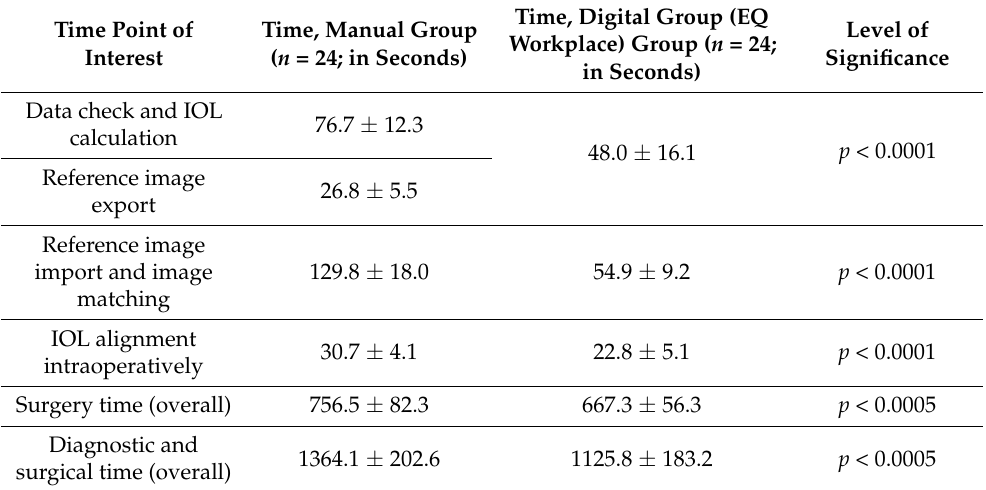
Table 2. Time measurements at the time points of interest in the manual and digital